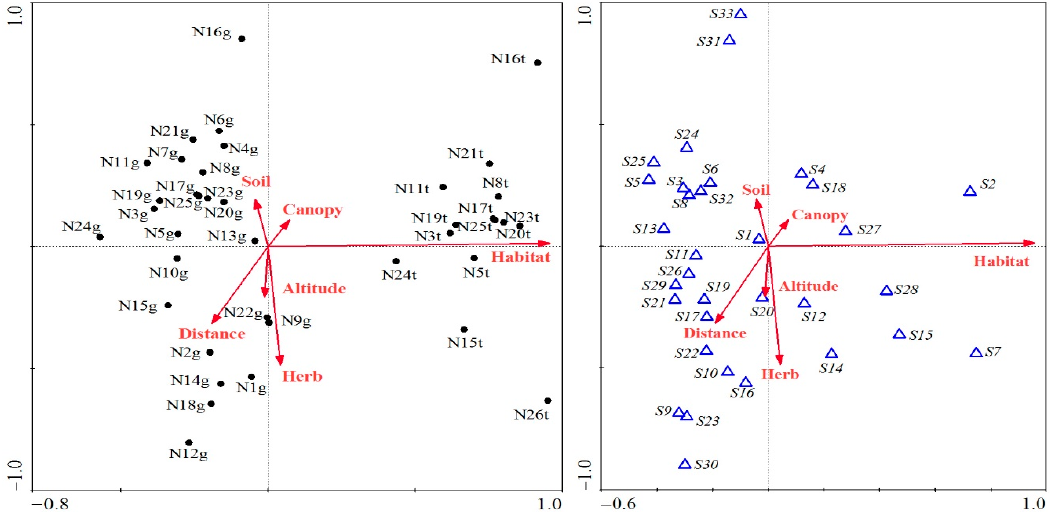
Figure 3. Canonical correspondence analysis of the relationships between bryophytes and environmental factors in Wuhan. The black points represent all sample sites with ground and epiphytic bryophytes, g means sample sites that showed ground bryophyte presence, and t indicates sample sites comprising epiphytic bryophytes. The blue triangles are the surveyed dominant bryophyte species, and the corresponding names are indicated in Table 2. Arrows are the environmental factors, where Habitat: habitat type of ground versus tree trunk; Canopy: coverage of tree canopy; Herb: coverage of herb layer; Distance: the distance to the nearest roads; Soil: soil water content; and Altitude: altitude of the sample sites.